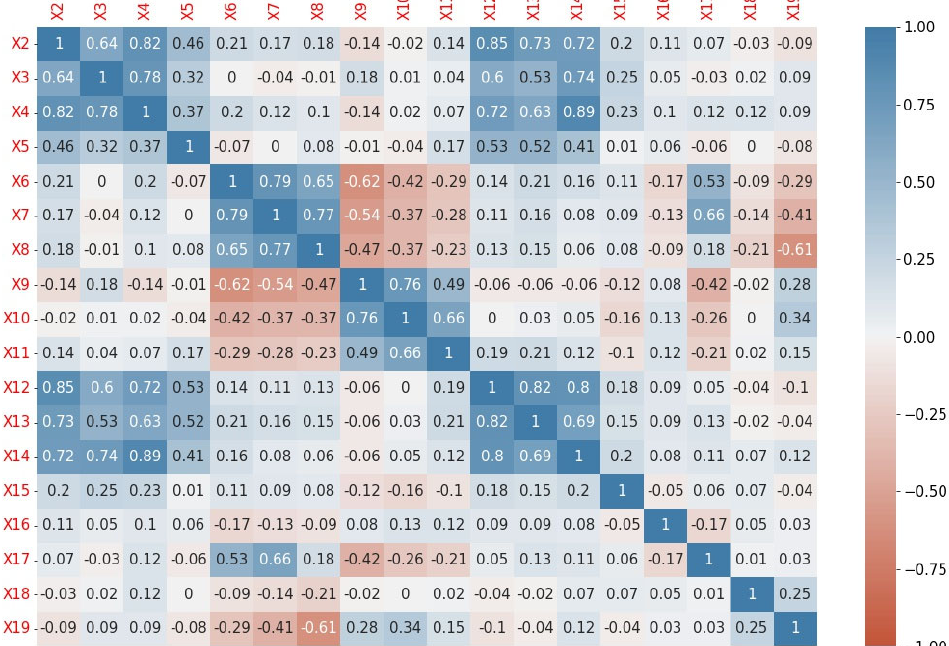
Table 7. The p ‐ values obtained from the Fisher test.